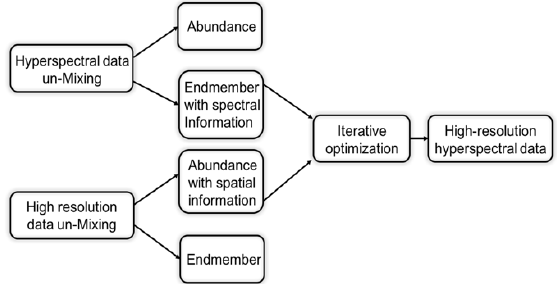
Fig. 2. Fusion working flow of HSI and MSI data.